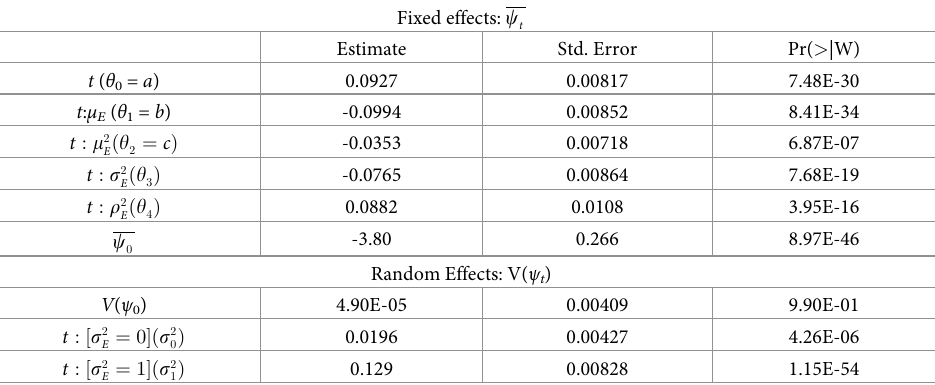
Table 1. Effects of the temporal mean μ E , variance s 2 environment on the mean (Fixed effets) and variance (Random effects) of strain C logit frequency ψ (Estimates, Standard errors and P-values from Wald test). All terms representing an interaction with time t measure an effect of the environment on